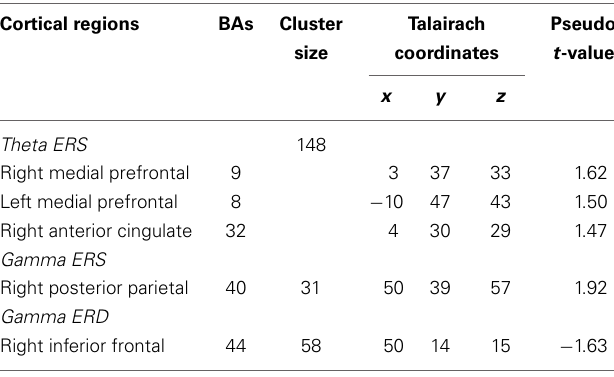
Table 1 | Cortical regions showing significant task-related activation or deactivation in different frequency